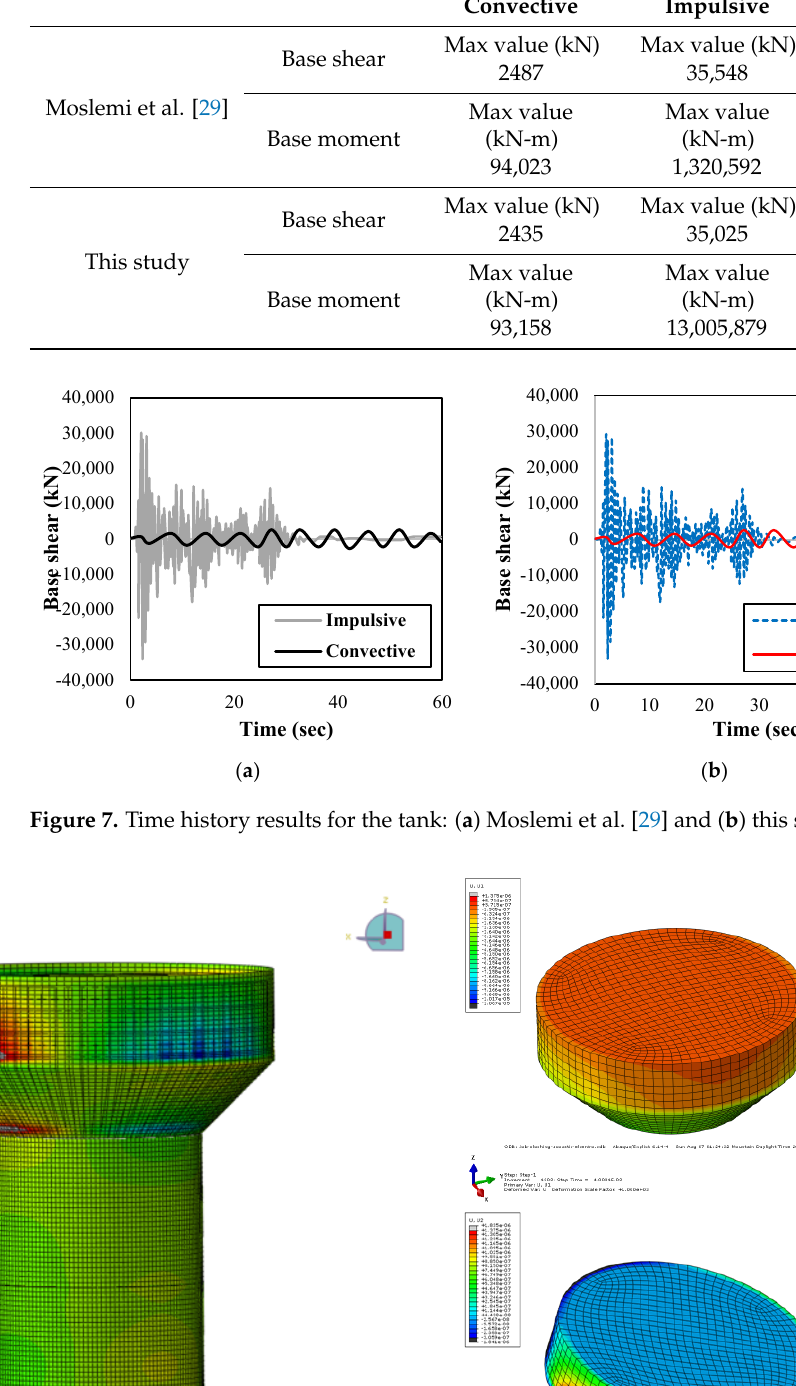
Figure 6. The El Centro earthquake’s ground motion: the horizontal component .